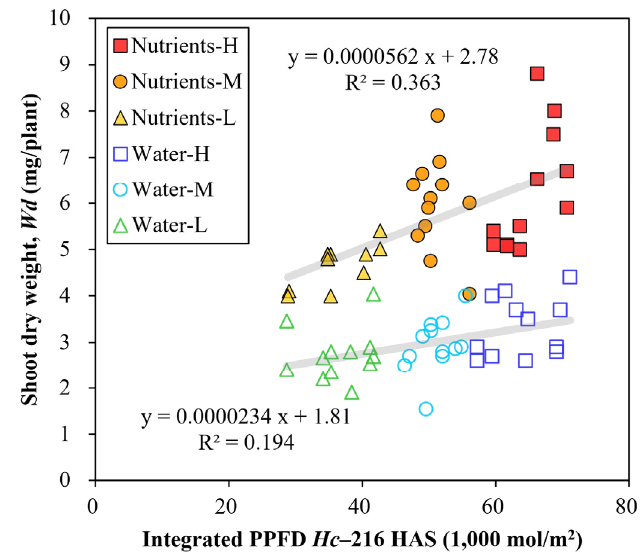
Figure 6. Integrated photosynthetic photon flux density (PPFD) from cotyledon unfolding ( Hc ) to 216 h after sowing (HAS) of each seedling and shoot (cotyledon, true leaves, hypocotyl, and petiole) dry weight of individual seedlings 216 HAS ( Wd ), with nutrients and water, each with distributions of horizontal PPFDs (see Table 1 for treatments and codes).